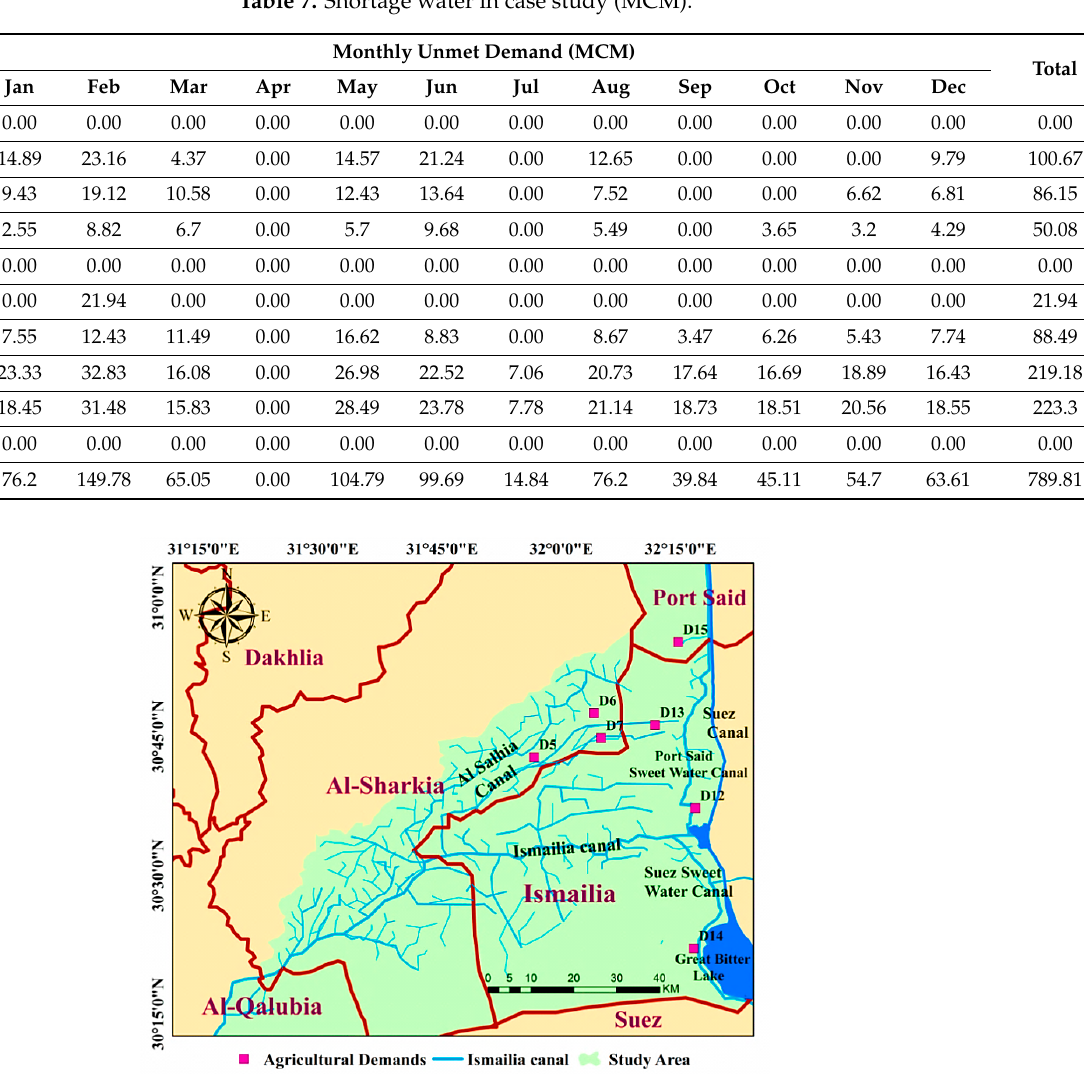
Figure 6. Location of agricultural areas that suffer from water deficits. Table 7. Shortage water in case study (MCM).